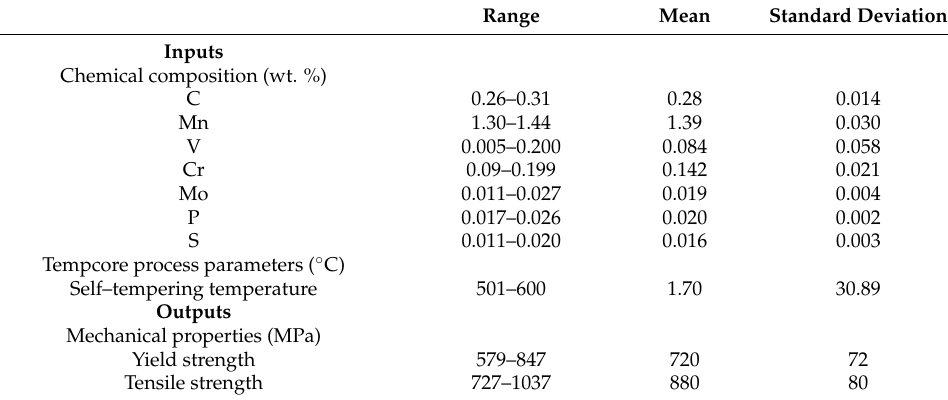
Table 3. Parameters and their ranges used in the